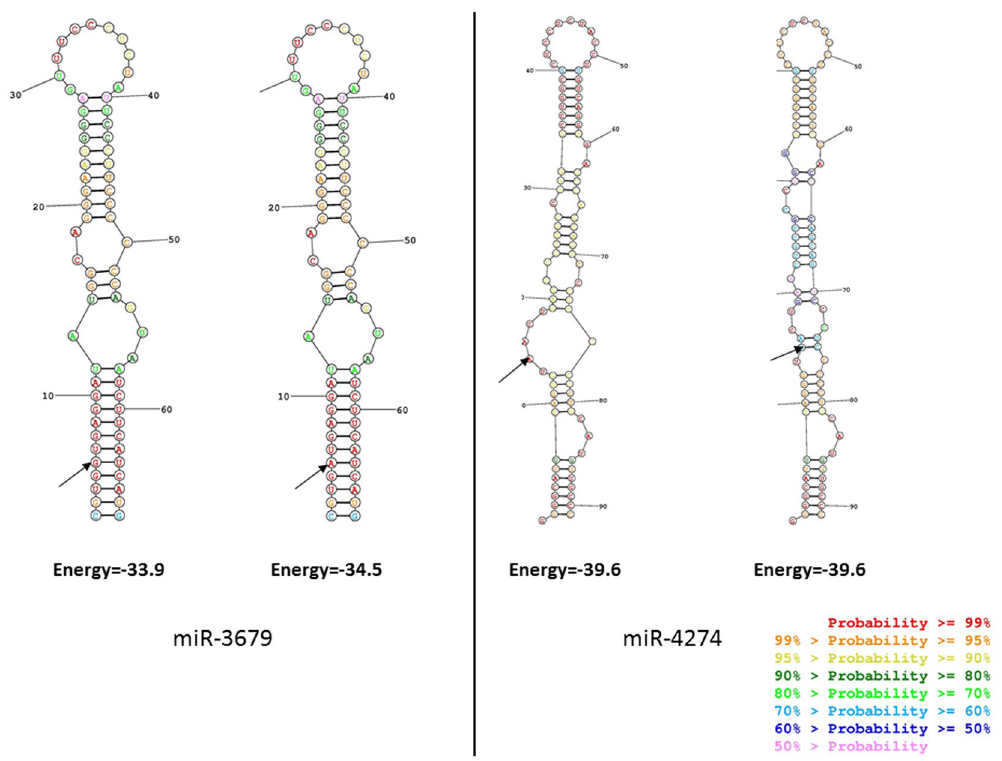
Figure 2. Predicted changes in secondary structure provoked by the BMD-associated SNPs according to RNAstructure web server. Black arrows tag the corresponding allele for rs6430498 in the miR-3679 and rs12512664 in the miR-4274.